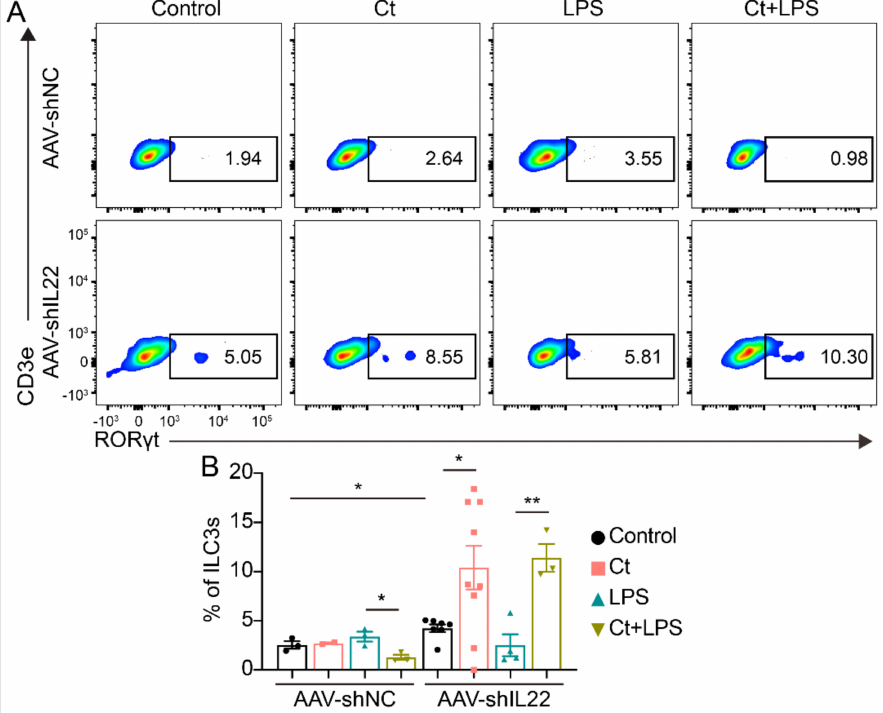
Figure 9. Effects of Ct on regulating colonic ILC3s in mice knocking down IL-22. Each dot presented one mouse. Data presented as mean ± SEM. * p < 0.05, ** p < 0.01 by two-way unpaired t